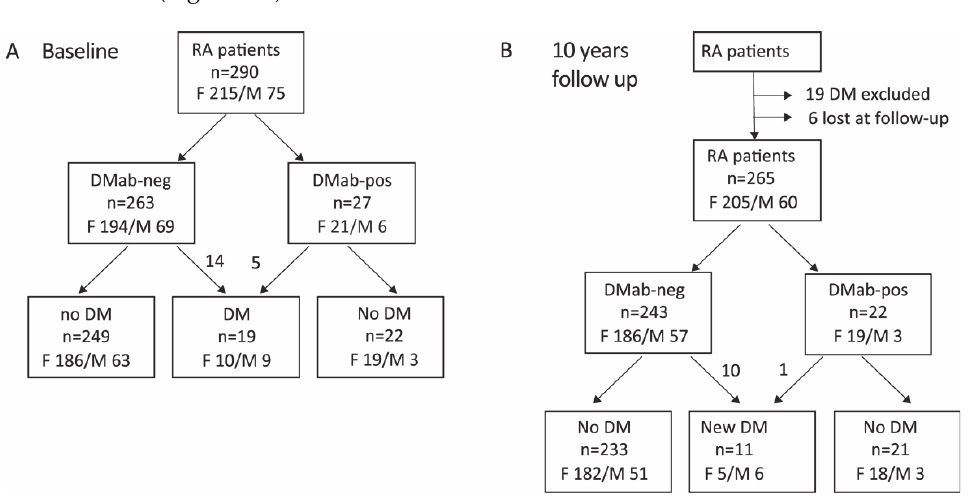
Figure 1. Flow chart of RA patients included in the study. ( A ) Baseline cohort. ( B ) Follow-up cohort. DM, diabetes mellitus; DMab, diabetes-mellitus-specific antibodies; RA, rheumatoid arthritis; M, male; F, female.